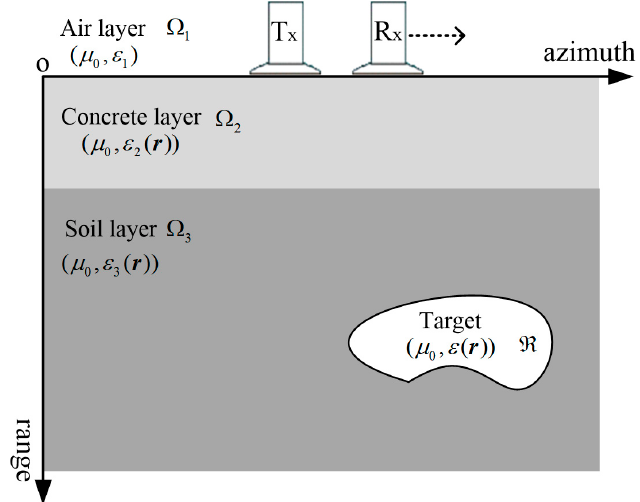
Figure 6. Layered media model structure diagram.